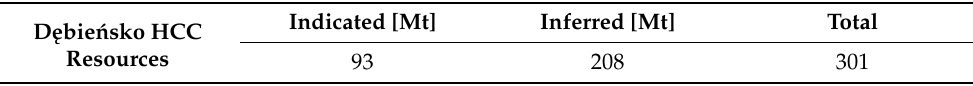
Table 2. D˛ebie´nsko hard coking coal (HCC) resources